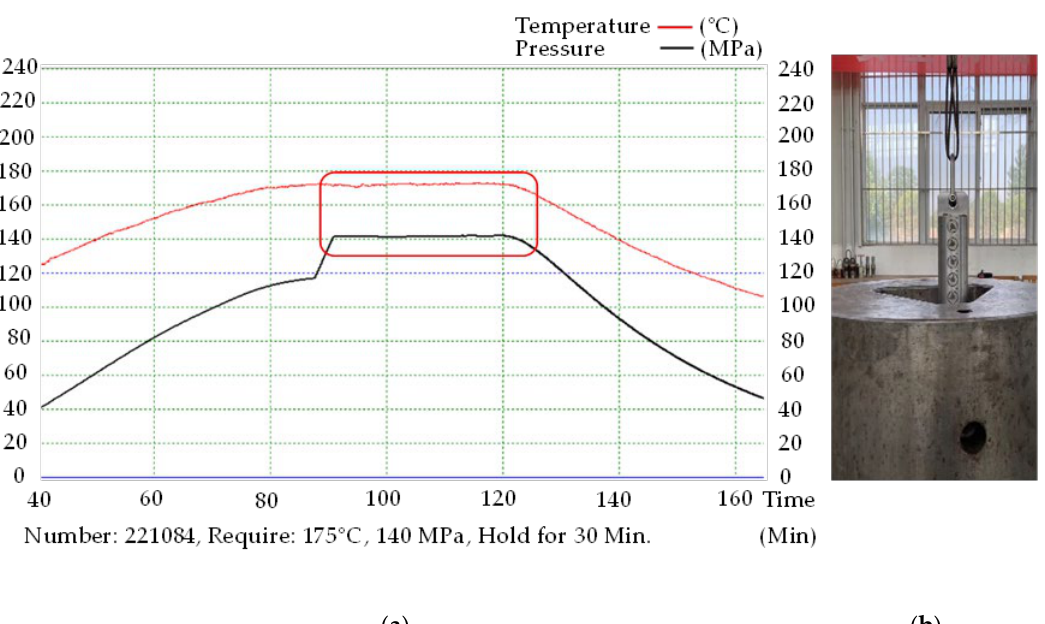
Figure 13. High-temperature and pressure resistance test: ( a ) high-temperature and pressure resistance test curve of antenna; ( b ) actual measurement diagram.